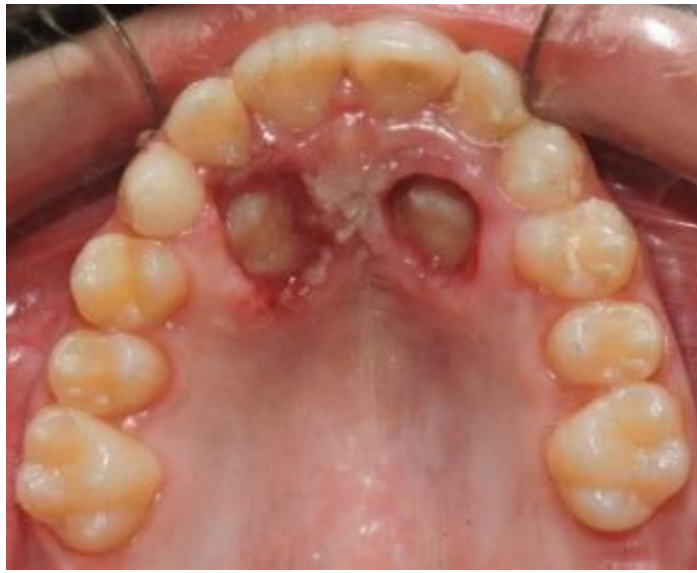
Figure 5. Intra-oral photo 7 days after surgery.